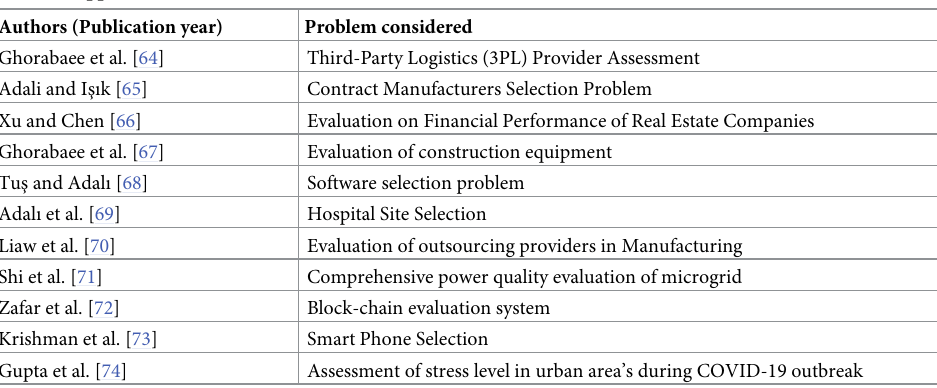
Table 3. Applications of the CRITIC method.